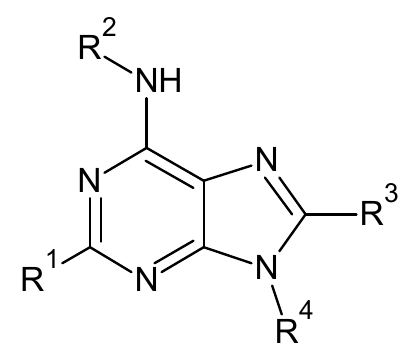
Figure 1. General structure of the adenosine compounds under